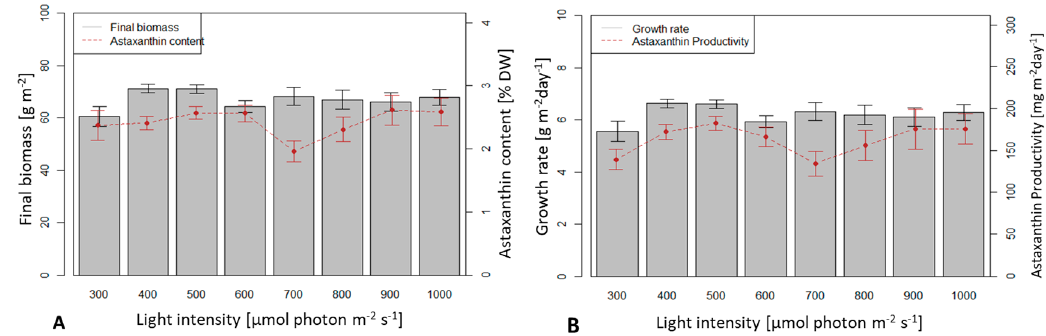
Figure 7. Biomass productivity and astaxanthin in H. pluvialis under different values of light intensities in the range of 300–1000 µmol photons m − 2 s − 1 . ( A ) Final biomass and astaxanthin content; ( B ) Biomass growth rate and astaxanthin productivity.